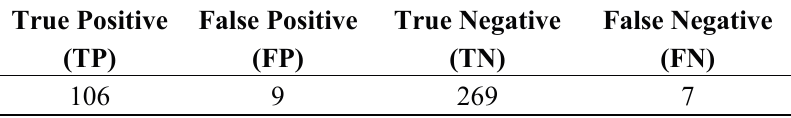
Table 13. Evaluation parameters for computing balanced